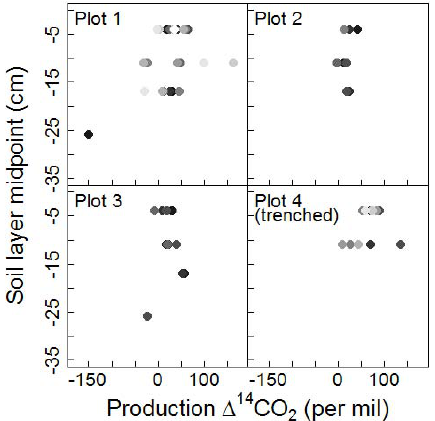
Fig. 8. Variation in estimated 1 14 CO 2 production profiles over the sampling period. Sampling days are distinguished by shade, from dark (late 2011 and early 2012) to light (late 2012). Because esti- mated errors are inflated by low production rates (see Eq. 9), we omitted ∼ 20% of observations where soil layer CO 2 production rate was ≤ 0.2µmolm − 2 s − 1